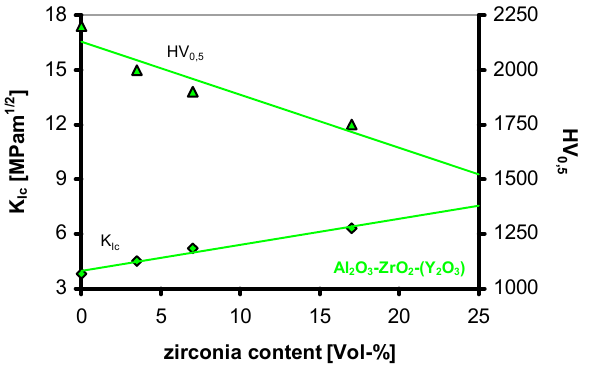
Figure 27. Fracture toughness and hardness in the system Al 2 O 3 -ZrO 2 (Y).